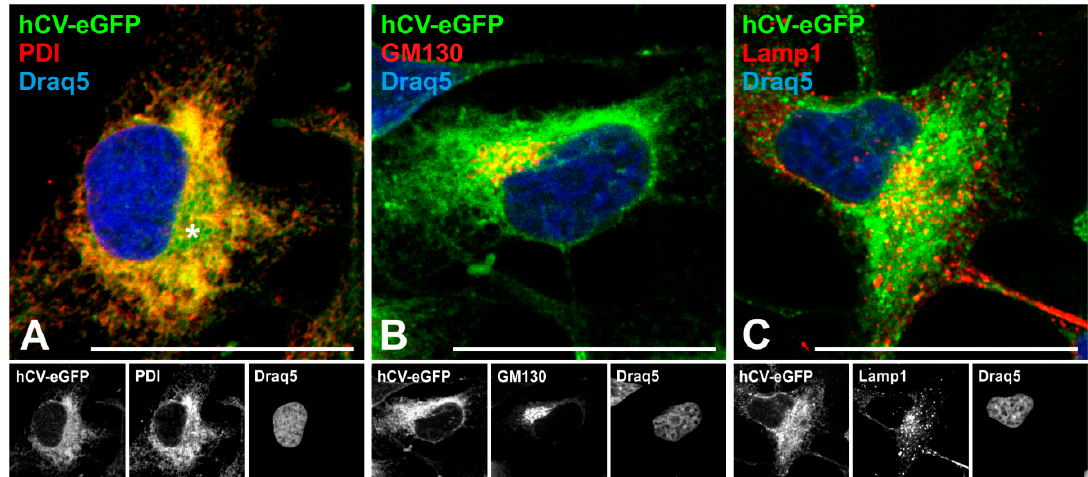
Figure 4. Trafficking of eGFP-tagged full-length cathepsin V in thyroid epithelial cells. Confocal laser scanning micrographs of Nthyori-CV cells expressing hCV-eGFP chimeras ( A – C , green signals) after immunolabeling with antibodies against PDI ( A ), GM130 ( B ) and Lamp1 ( C ) proteins residing in the ER, at the cytosolic face of Golgi cisternae and vesicles, and in endo-lysosomes, respectively (red signals). Yellow signals are indicative of co-localization. Nuclei were counter-stained with Draq5™ (blue signals). Single-channel fluorescence micrographs are depicted in the bottom panels as indicated. Scale bars represent 50 μ m.